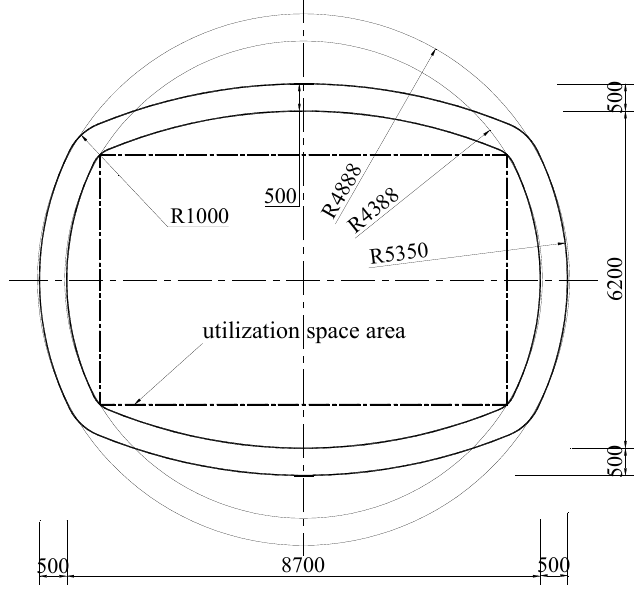
Figure 2. Circular tunnel with the same utilization space area, distances in millimeters.